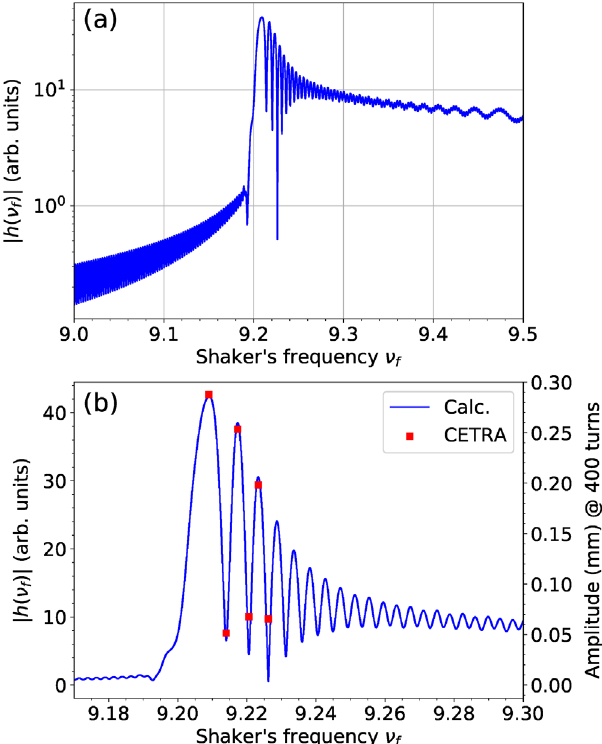
FIG. 3. Frequency response of the oscillation amplitude at the 400th turn. (a) The scale for the y axis is logarithmic. (b) The scale for the y axis is linear. Red squares represent the oscillation amplitude at the 400th turn calculated from single-particle tracking by CETRA .